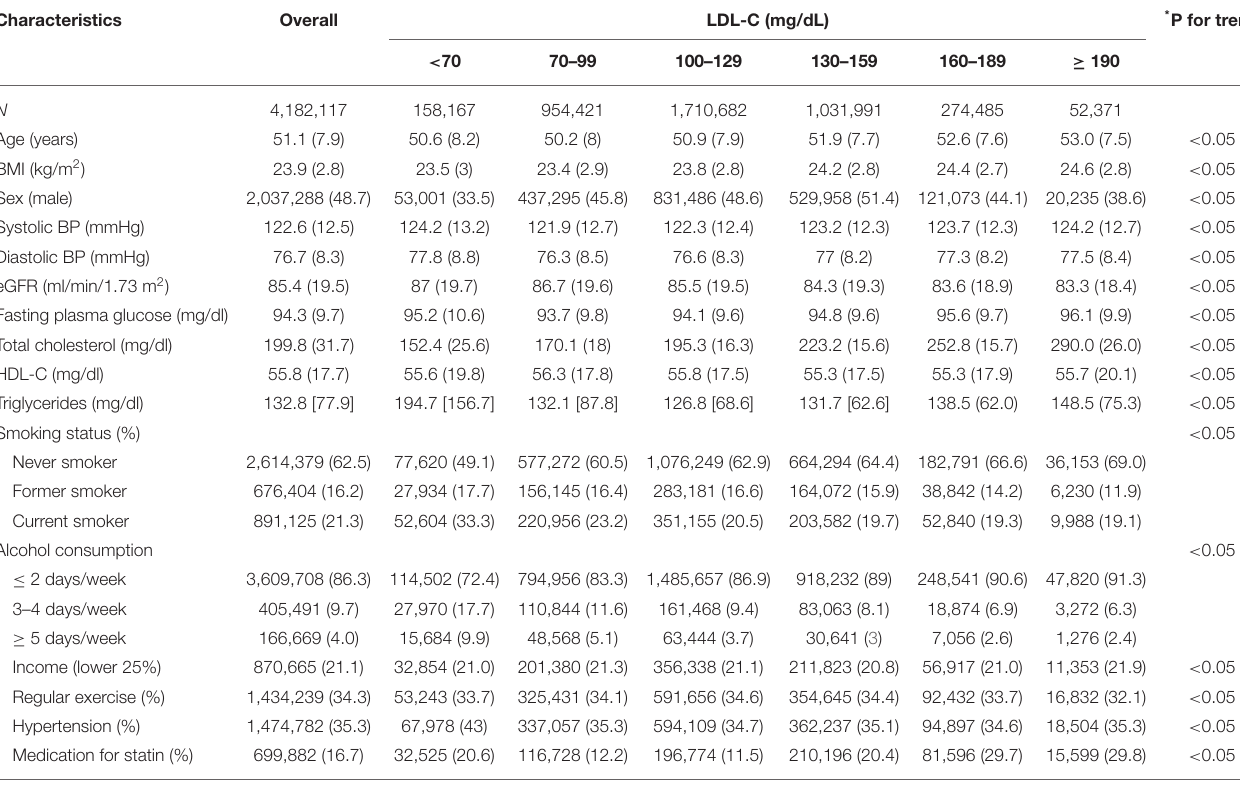
TABLE 1 | Baseline characteristics of participants according to LDL-C concentrations.